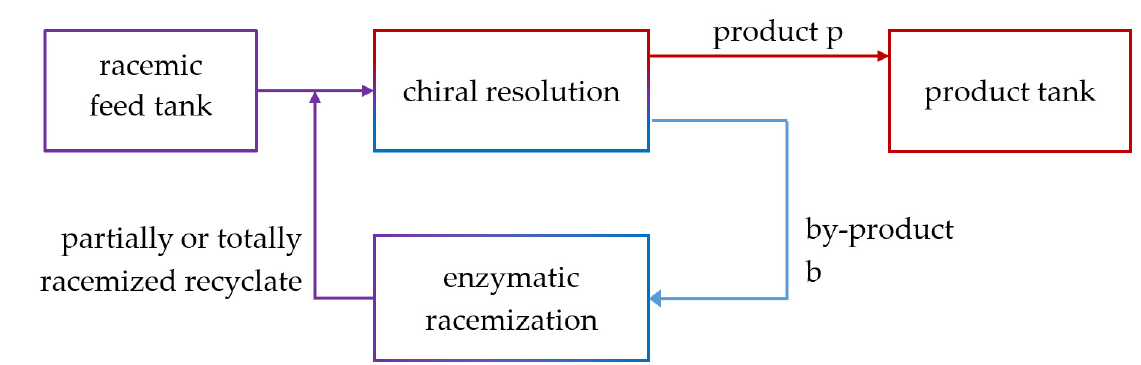
Figure 1. Principle of an integrated process including a chiral resolution step to provide the target enantiomer (product p) and enzymatic racemization of the by-product b followed by recycling the reactor effluent back to the chiral resolution step (recycling into the feed tank is also an option).